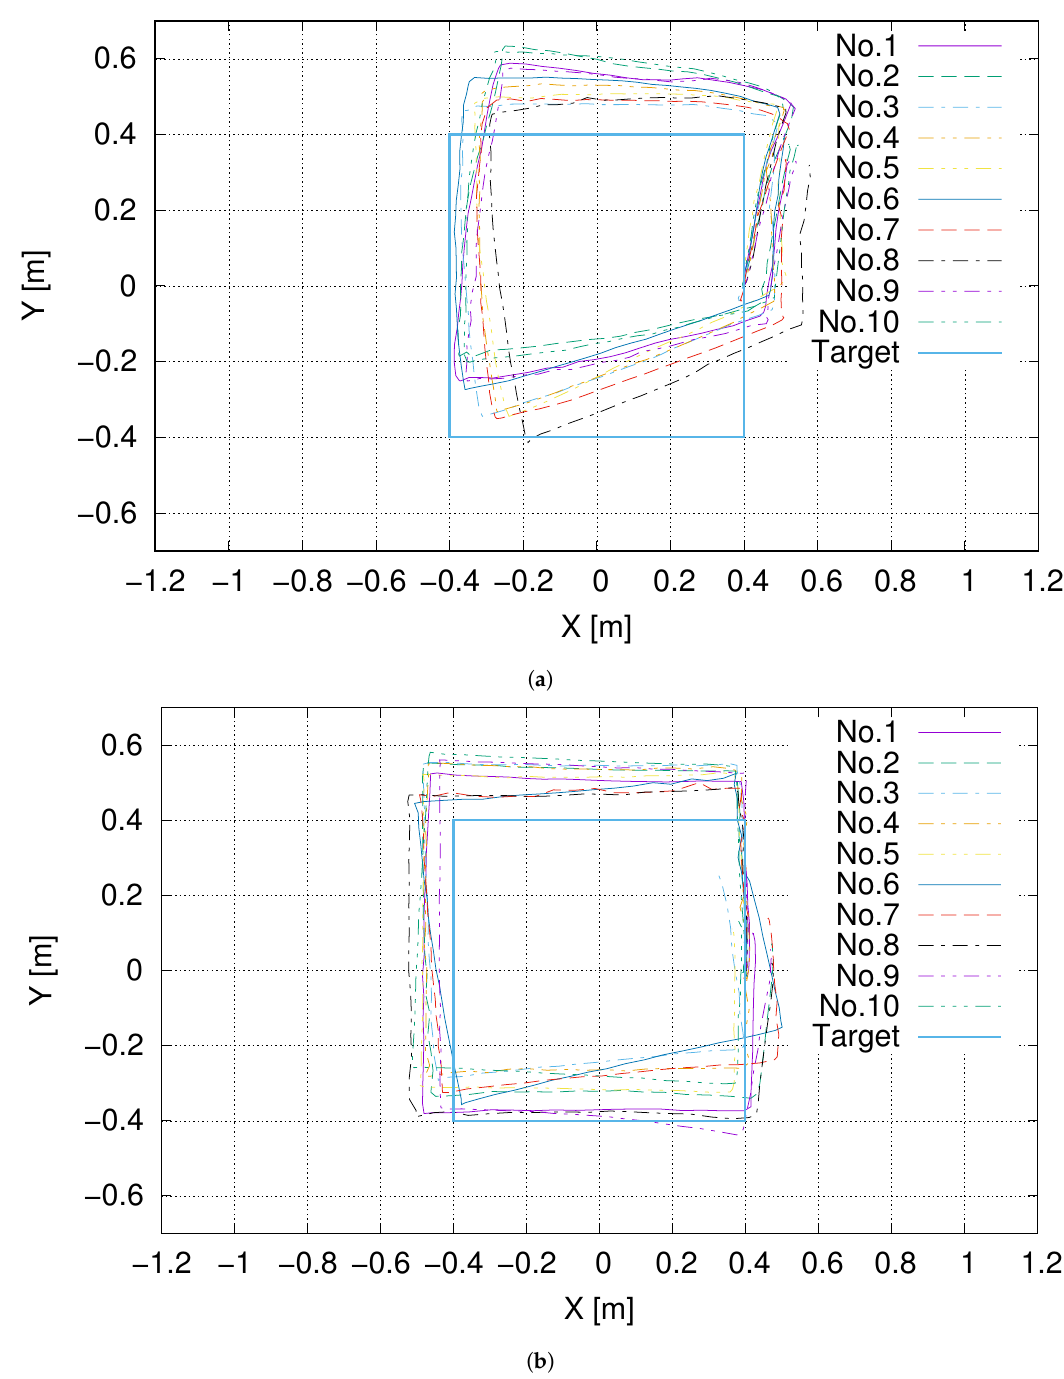
Figure 6. The robot trajectory during each run using square pattern. ( a ) Conventional robot; ( b ) pro- posed